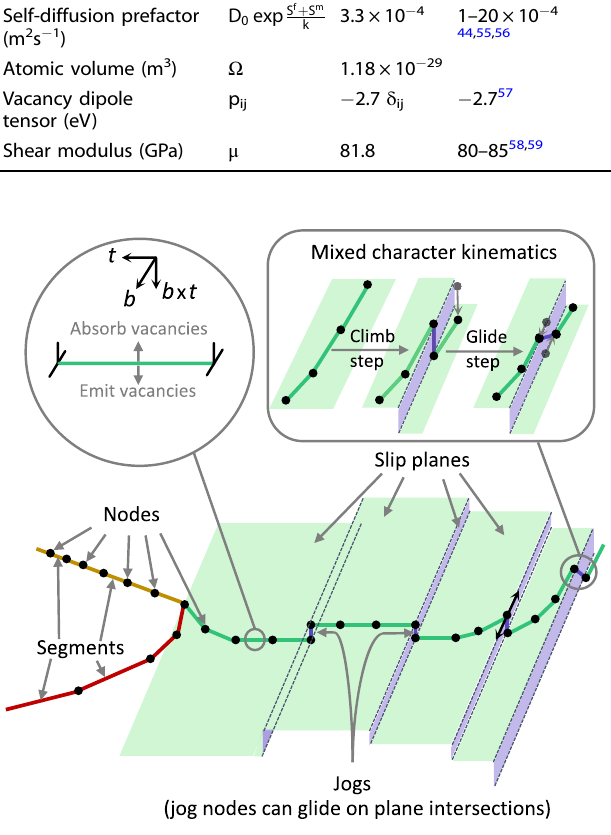
Fig. 10 The kinematics of climb for mixed character dislocations in the nodal discrete dislocation dynamics framework. Jogs are added to the network as needed to ensure all segments remain within well-de fi ned slip planes.